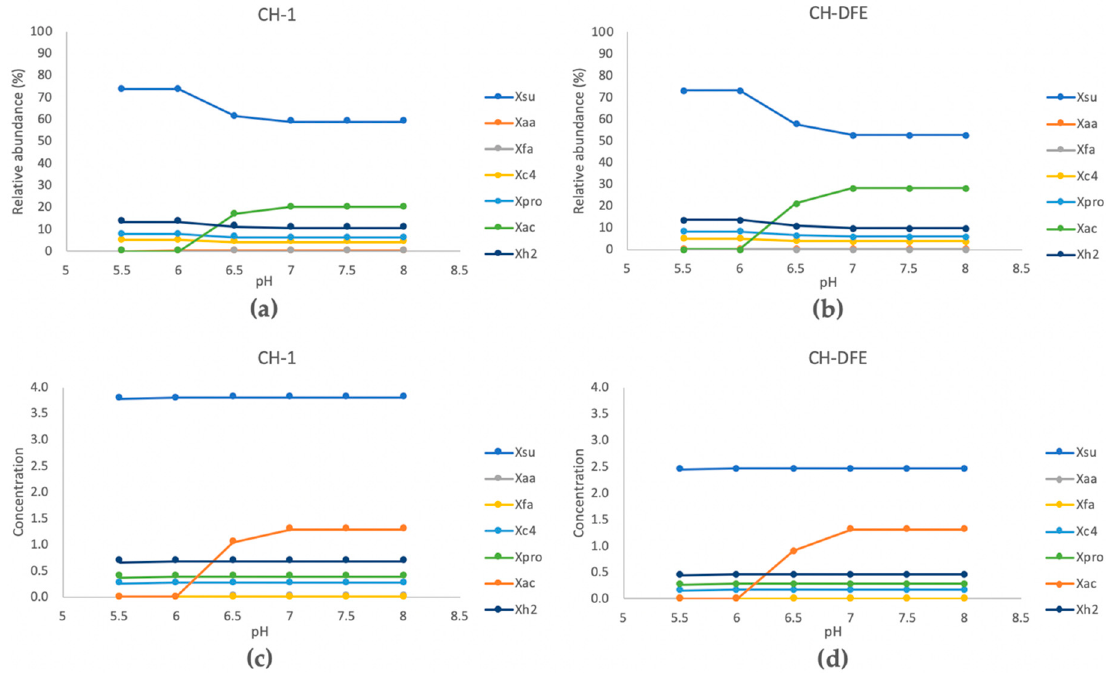
Figure 6. Key microbial population dynamics predicted by anaerobic digestion model no. 1 (ADM1), divided into four functional groups: acidogens (Xsu, Xaa, and Xfa), acetogens (Xc4 and Xpro) hydrogen degraders (Xh2), and acetate degraders (Xac). ( a ), ( b ) Predicted relative abundance and ( c ), ( d ) predicted absolute abundance.